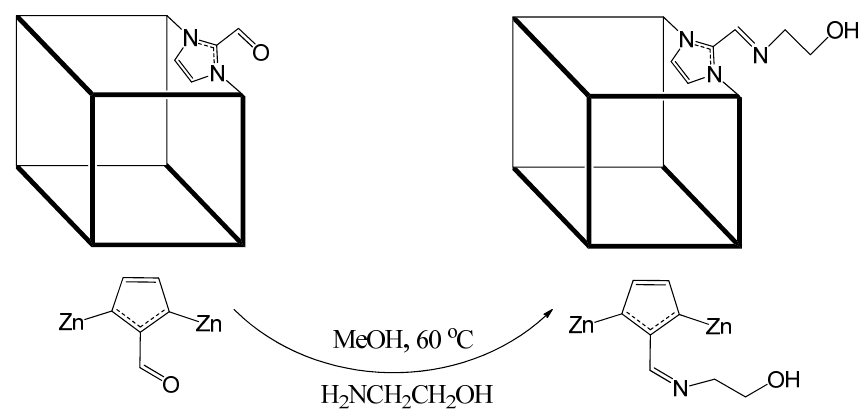
Figure 2. Imine condensation reaction of ZIF-90 with ethanolamine for 50-PSM-ZIF-90